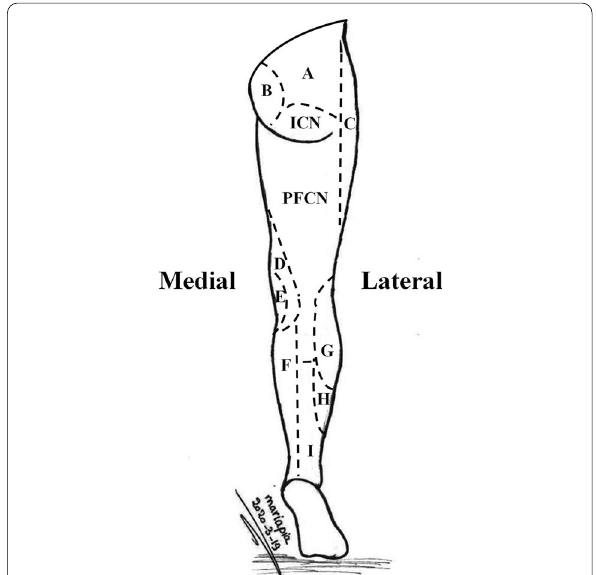
Fig. 2 Sensory territory of the posterior femoral cutaneous nerve (PFCN) and its branch “inferior cluneal nerve (ICN)” in relation to the sensory territories of other nerves that supply the posterior aspect of the buttock, thigh and leg [4–6, 8]. They are: superior cluneal nerve ( A ), middle cluneal nerve ( B ), lateral femoral cutaneous nerve (lateral cutaneous nerve of the thigh) ( C ), medial femoral cutaneous nerve (medial cutaneous nerve of the thigh) ( D ), obturator nerve ( E ), saphenous nerve ( F ), lateral sural cutaneous nerve (lateral cutaneous nerve of the calf) ( G ), superficial peroneal nerve ( H ) and sural nerve ( I